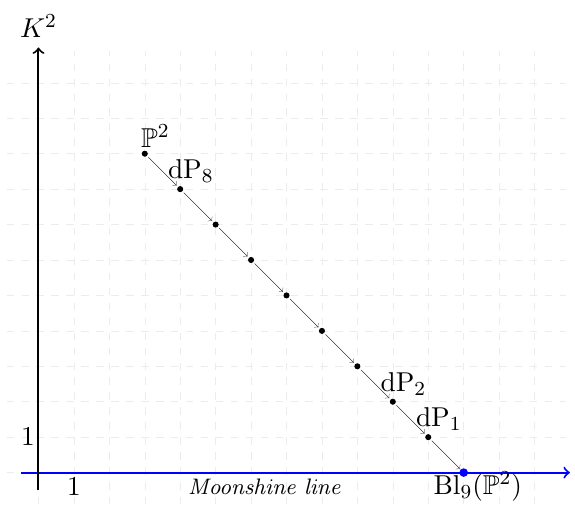
Figure 1 . Blow-up orbit of P 2 towards the moonshine